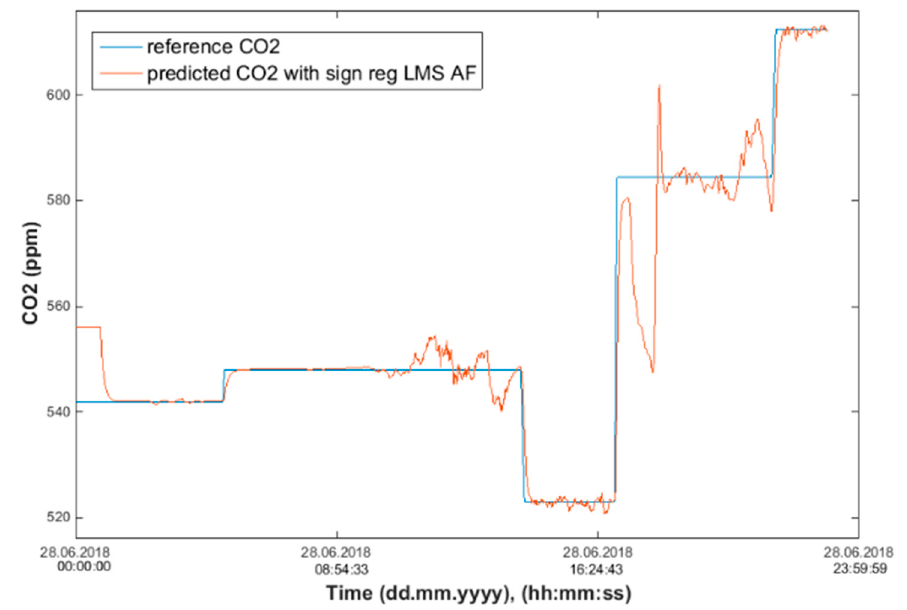
Figure 23. Comparison of the reference and predicted CO 2 waveforms (SRLMS AF) from 28 June 2018 in R104 with an ANN with 60 neurons and SCG method trained with data from 25 June 2018 in R203.